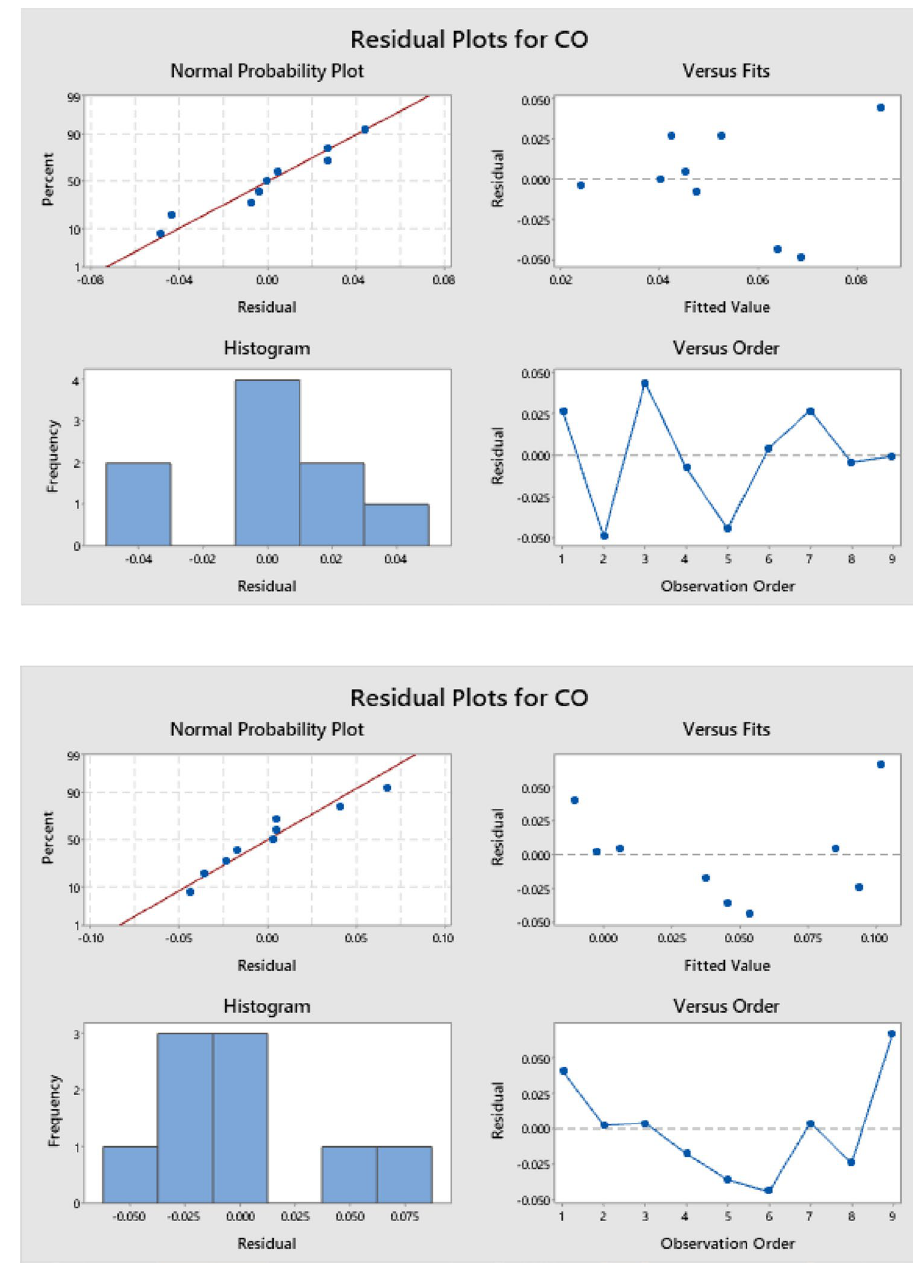
Fig. 14 Residual plot for CO without nanoparticles